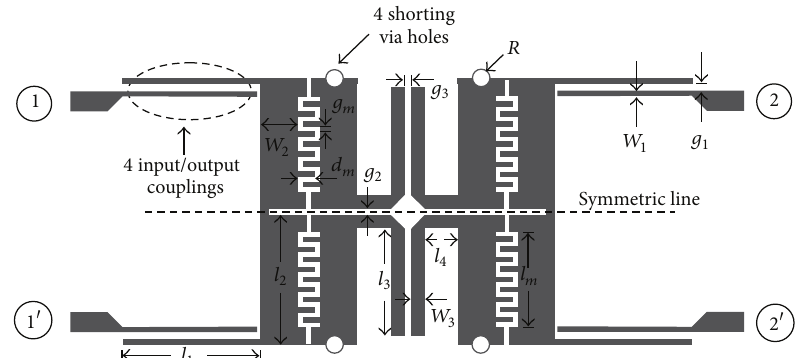
Figure 19: Configuration of the proposed balanced dual-band band-pass filter using coupled stepped-impedance resonators [3].